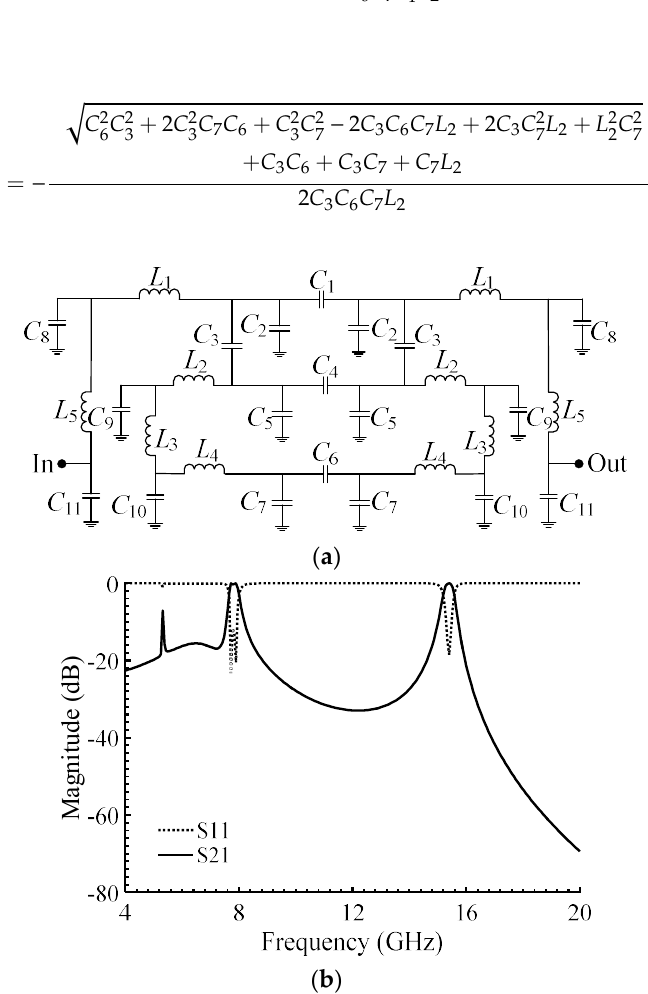
Figure 3. Bended coupling system: ( a ) lumped-element circuit (LC) model, ( b ) LC simulation. The lower passband can be tuned by varying the line gap (A6) since increasing A6 would result in a smaller capacitor, shifting up the resonant frequency as depicted in Figure 4. Additionally, the insertion loss increases by moving the lower passband to higher frequencies. Therefore, for keeping an optimum response, A6 is fixed at 0.1